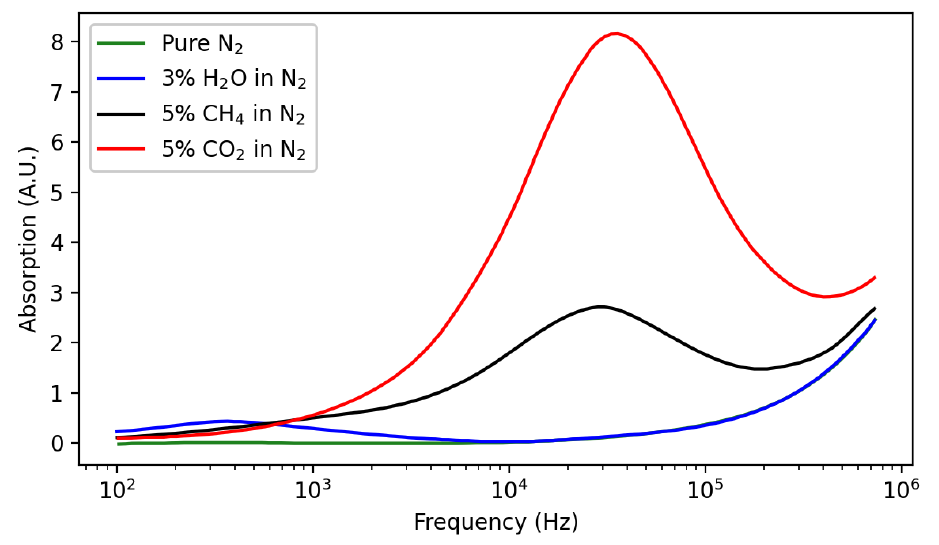
Figure 11. Acoustical absorption spectra of diverse nitrogen mixtures. Data source: Petculescu et al.